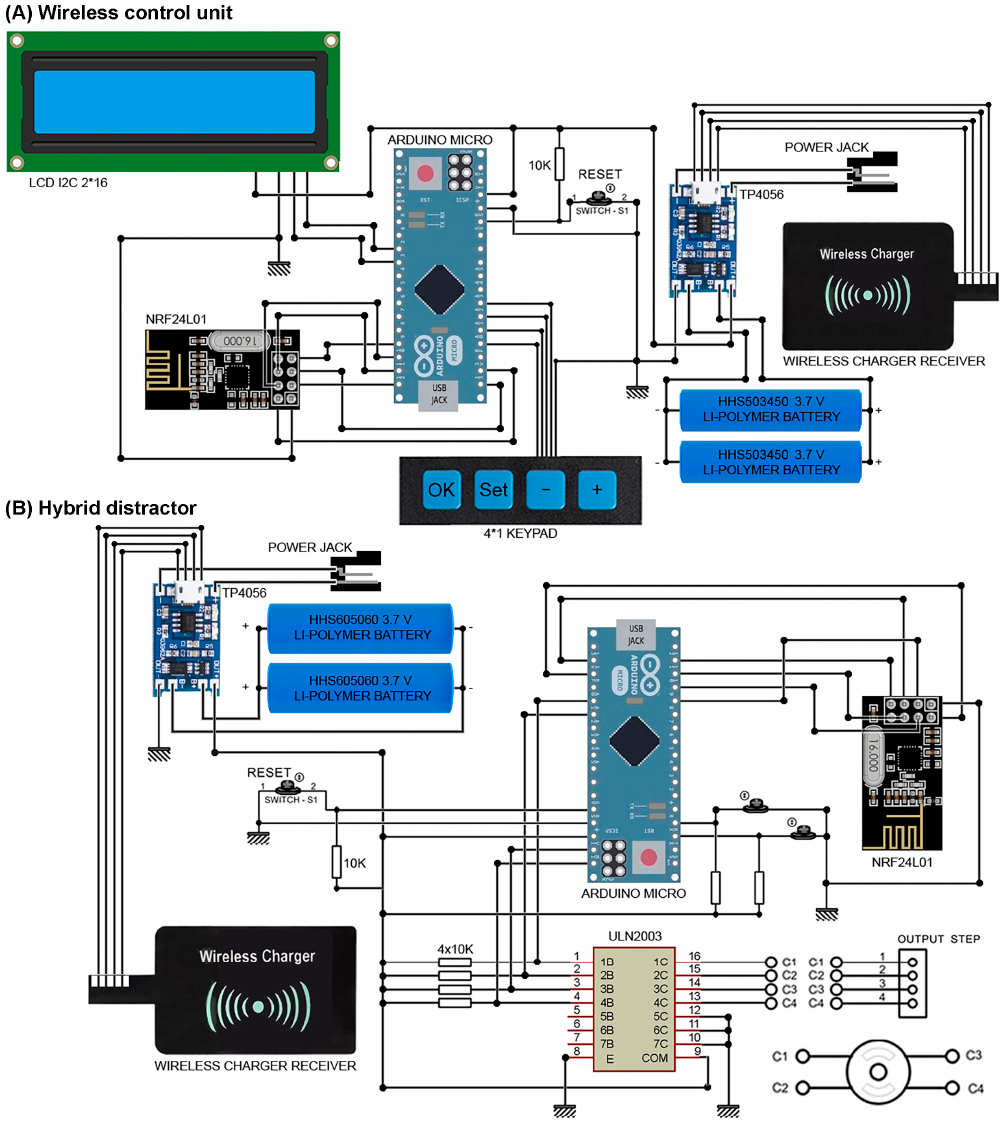
Figure 3. The detailed design of the control system: ( A ) Wireless control unit and ( B ) Hybrid distractor.